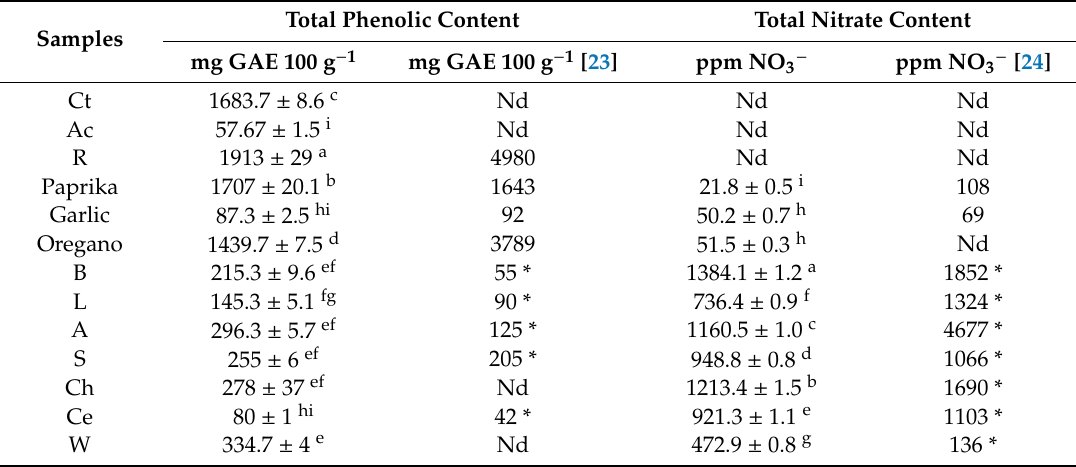
Table 2. Total phenolic content (TPC) (mg GAE 100 g − 1 ) and total nitrate content (TNC) (ppm NO 3 − ) in natural extracts (M ± SD), together with their comparison with USDA [23] and EFSA [24]